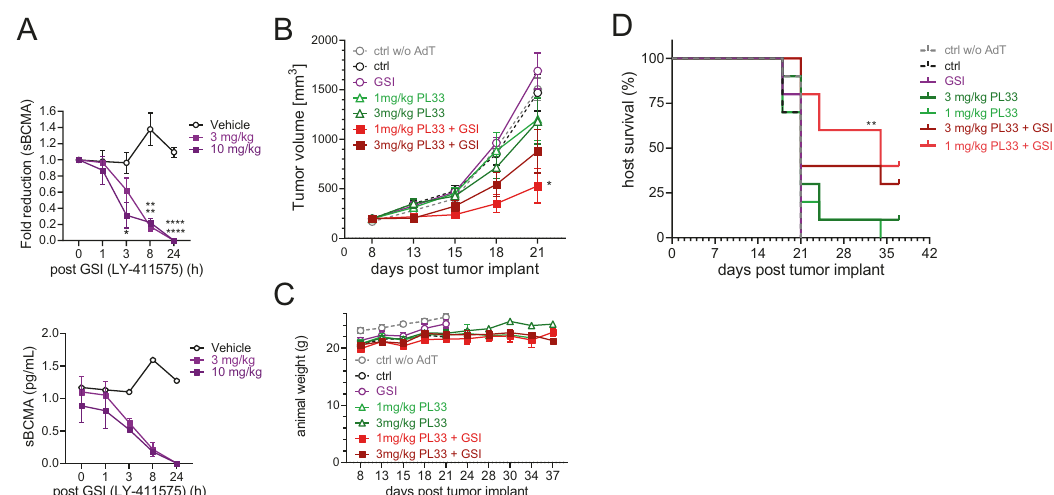
Fig. 7 GSI rapidly and effectively cleared sBCMA released from MM tumors in mouse serum and further improved in vivo anti-MM activity of BCMAxCD3 BisAb with extended host survival. A NSG mice were inoculated with KMS11-luc cells subcutaneously on the right fl ank at d0 and administered a single dose of GSI (3 (light purple square) and 10 (dark purple square) mg/kg LY-411575), or vehicle treated control (black open circle) when tumor volume reached ~325 mm 3 . Serum was serially collected following indicated time periods to evaluate sBCMA levels. Shown are fold reduction in sBCMA from baseline (time 0) (upper panel) and sBCMA pg/mL (lower panel). Data are presented as means ± SEMs (error bars). B – D NSG mice were injected with PBMCs (AdT) 5 days prior to KMS11-luc cell implantation on d0 and mice were randomized into their respective groups on d8 when average tumor size was ~200 mm 3 . LY-411575 (3 mg/kg, QDx2) was administered PO as a single agent GSI and in combination groups. On the following day (d9), the second dose of LY41175 was administered followed by a single dose of PL33 to the single agent PL33 groups and combination groups at a dose 1 or 3 mg/kg IV. Cohorts included: 3 mg/kg LY-411575 (purple circle), 3.0 mg/kg (dark green triangle) or 1.0 mg/kg (light green triangle) PL33, LY-411575 + 3 mg/kg PL33 (maroon solid square) LY- 411575 + 1 mg/kg PL33 (red solid square), tumor only (ctrl, black circle), tumor without PBMCs (ctrl w/o AdT, gray circle). B Shown are mean tumor volumes (mm 3 ) ± SDs (error bars) at following days vs. start of treatment. * P < 0.05 for tumor growth inhibition of single agent